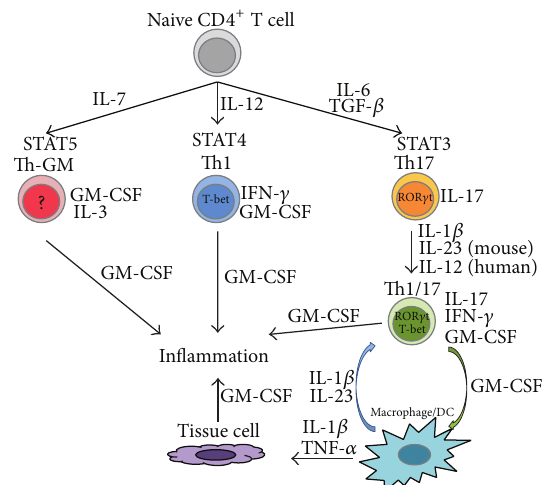
Figure 1: The differentiation of GM-CSF-producing CD4 + T cells and cytokine networks. Activated macrophages and dendritic cells (DCs) produce proinflammatory cytokines such as IL-23, IL-1 𝛽 , and IL-6, which can promote the differentiation of Th17 and Th1/17 cells, leading to more GM-CSF production from Th1/17 cells. Increased levels of GM-CSF upregulate further production of proinflamma- tory cytokines from macrophages/DCs, creating a positive feedback loop. Activated macrophages/DCs also produce proinflammatory cytokines, such as IL-1 𝛽 and TNF 𝛼 , which stimulate the production of GM-CSF from resident tissue cells, including endothelial cells, epithelial cells, fibroblast, or